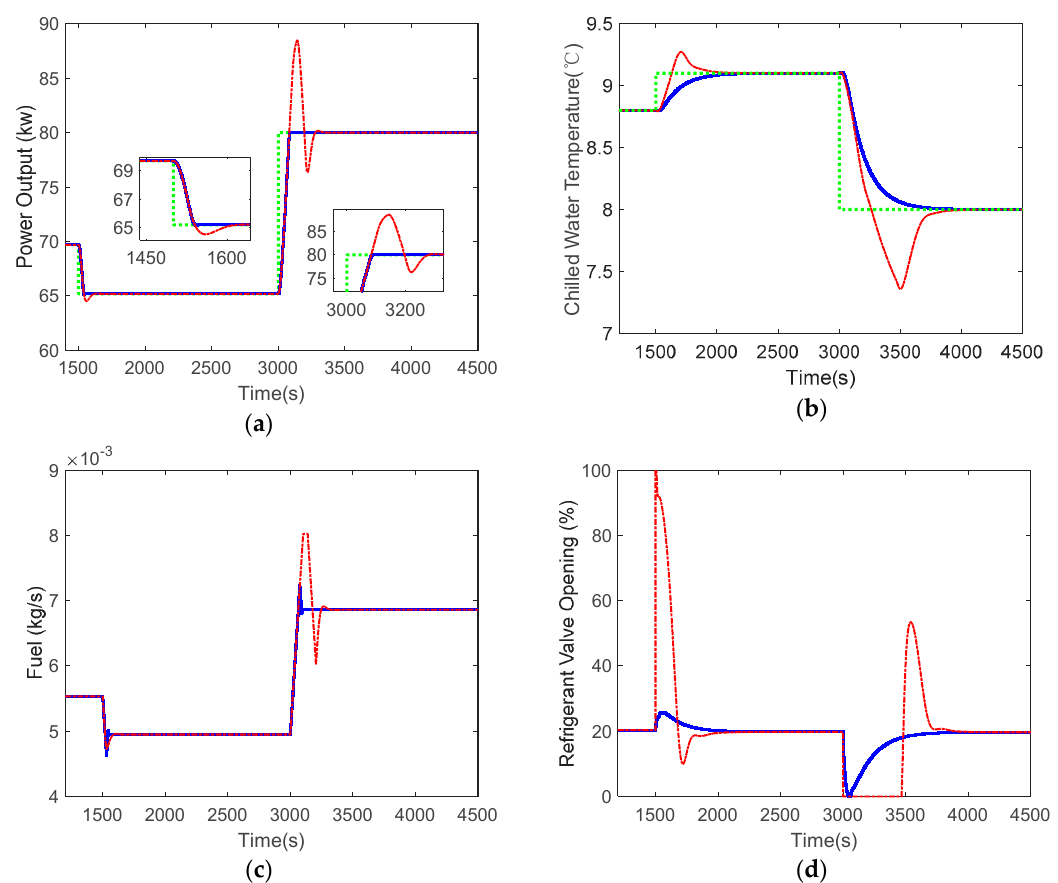
Figure 12. Case 1: Load tracking performance of the MGT-CCP system (Solid in blue: proposed method;